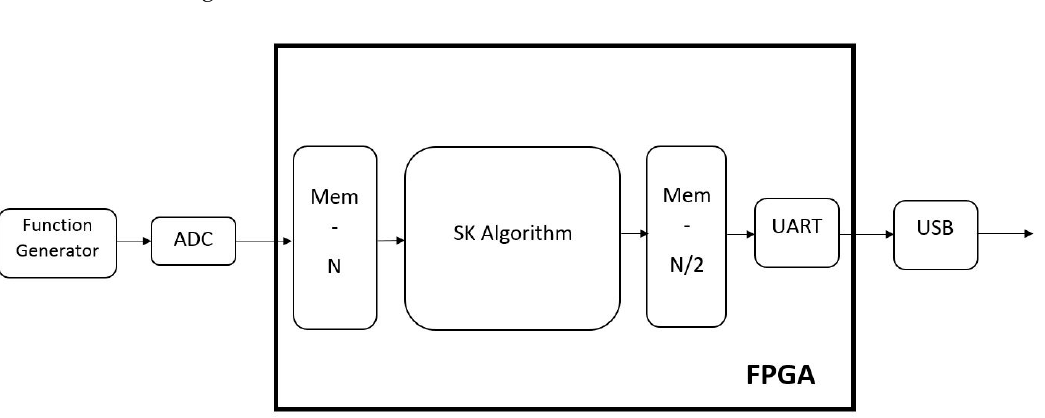
Figure 2. Experimental setup for FPGA implementations.